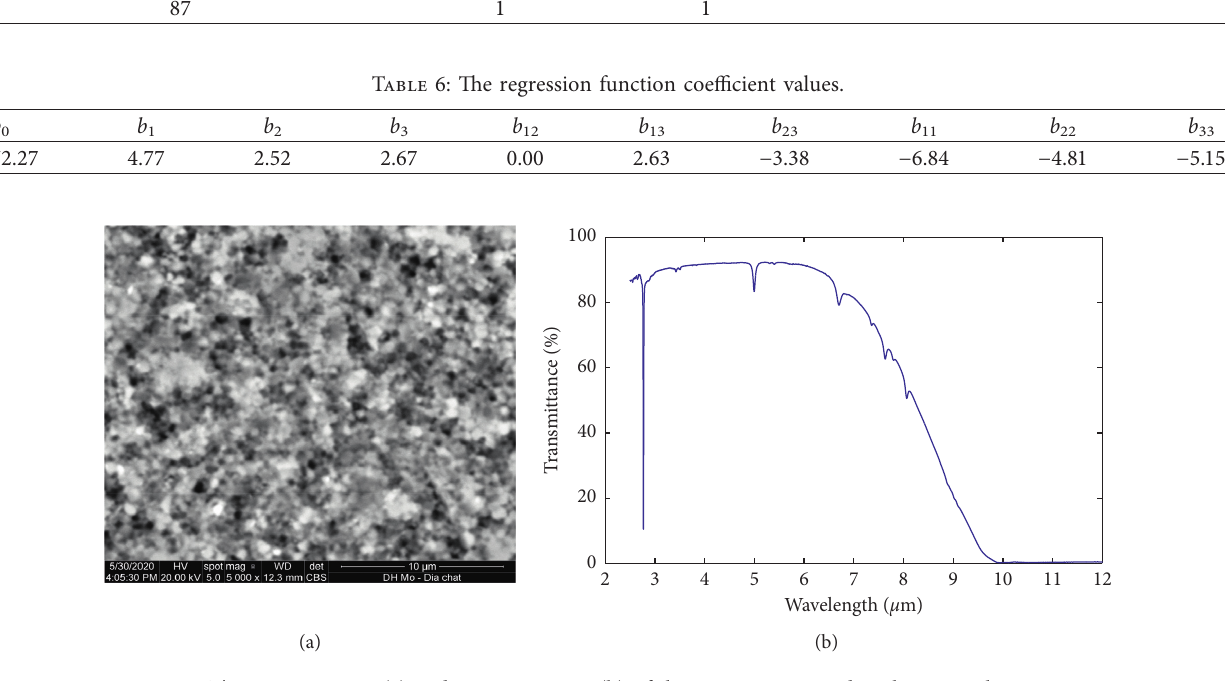
Figure 5: The transmittance (a) and microstructure (b) of the ceramics sintered at the optimal parameters.